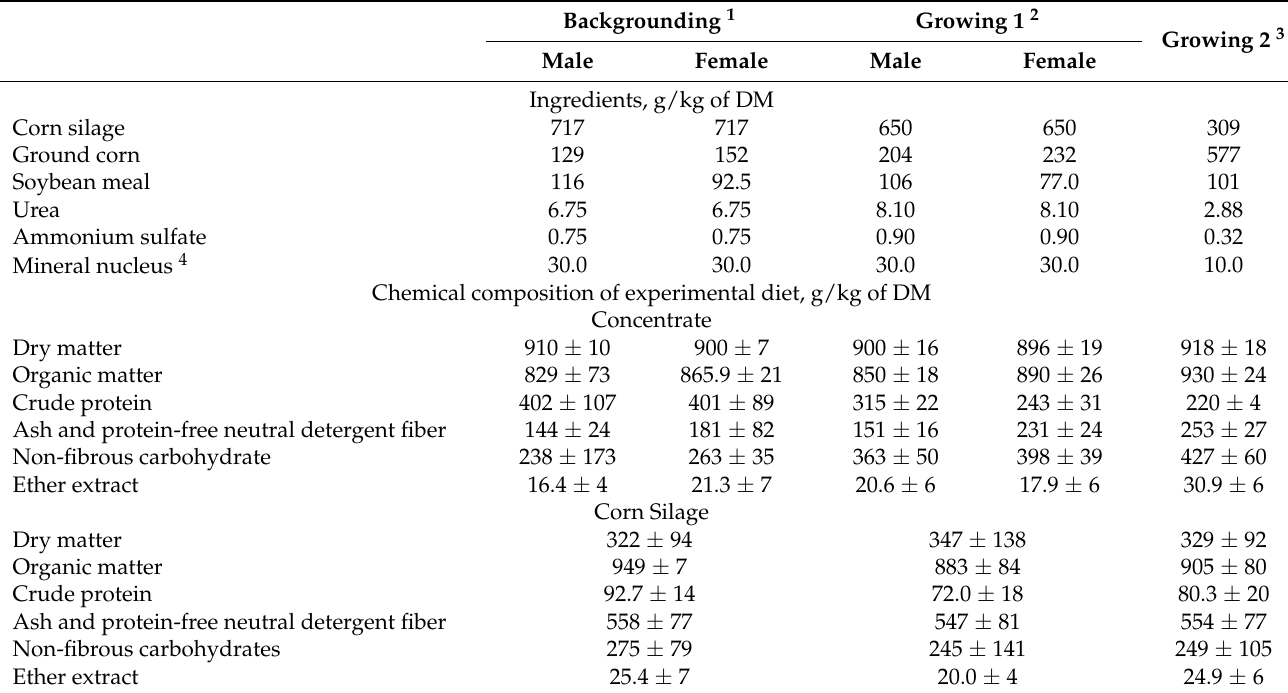
Table 2. Ingredients and chemical composition of the feedstuffs used in the